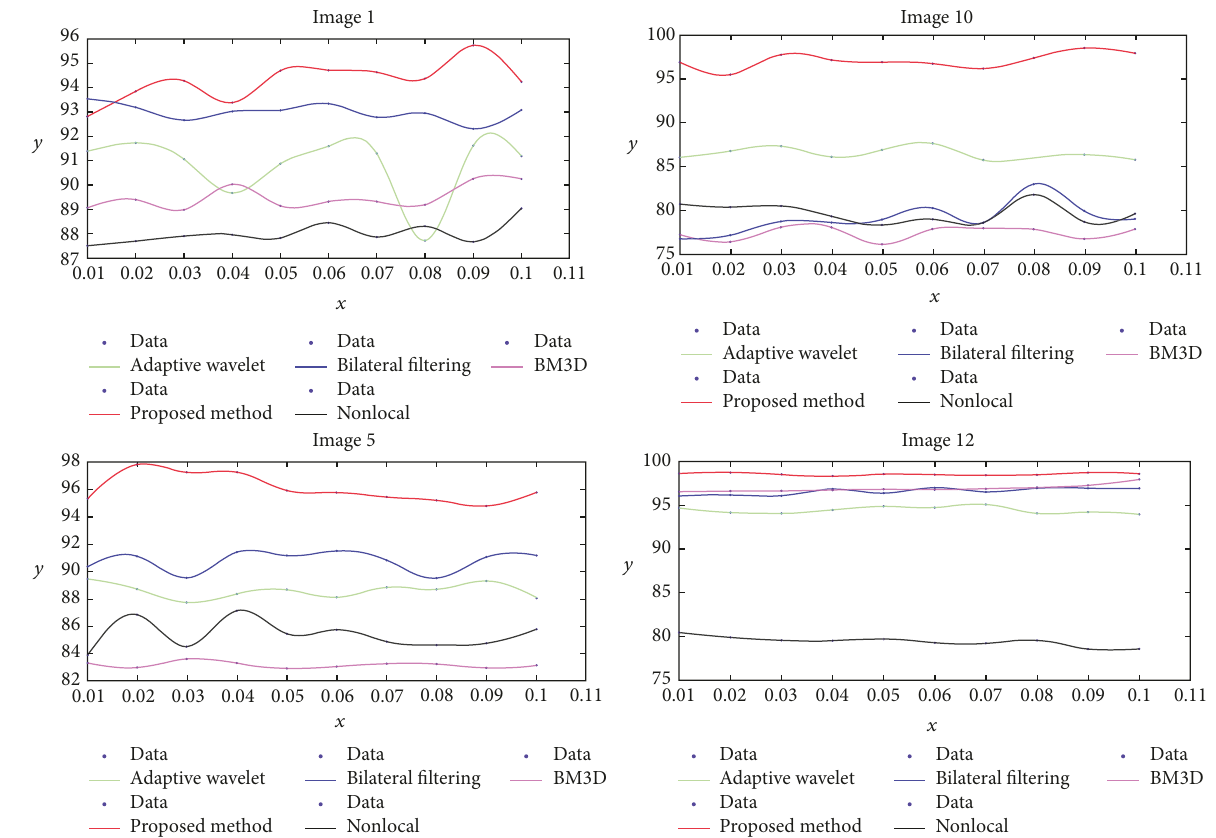
Figure 15: Pratt’s figure of